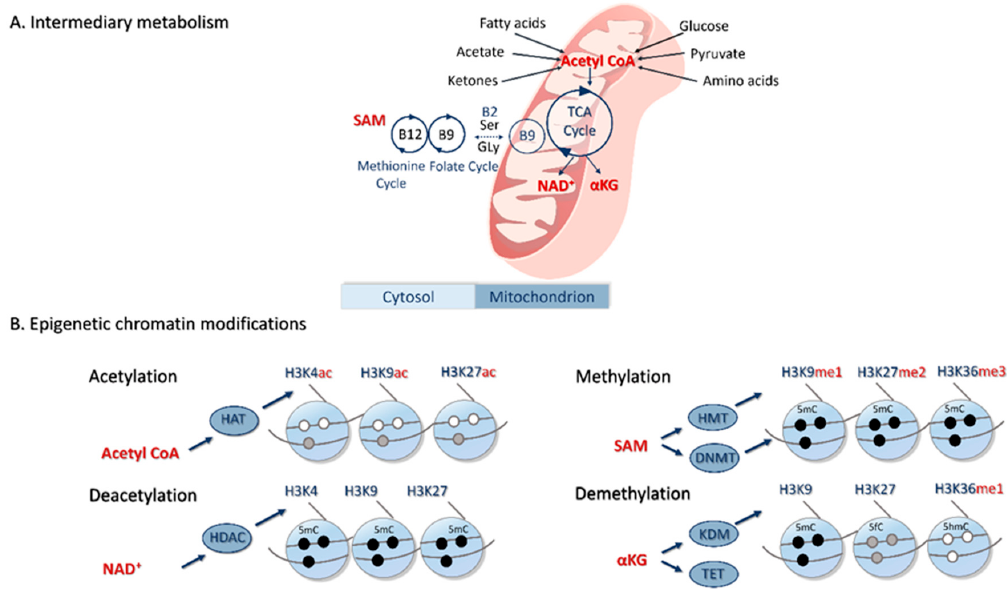
Figure 3. Alterations to intermediary metabolism ( A ) that can result in epigenetic modifications to chromatin ( B ). Intermediary metabolism can be altered directly by dietary composition (during sensitive periods; see Figure 1), and / or by eating disorders and the gut microbiome (see Figure 2). This in turn can alter the availability of various intermediary metabolites that serve as substrates and co-factors for enzymes involved in chromatin modification (Histone acetyltransferases (HAT) and Histone deacetylases (HDAC; e.g., Sirtuins), Histone methyl transferase (HMT) and DNA methyltransferases (DNMTs), Histone (lysine) (KDM) and Ten-Eleven Translocation (TET) demethylases) [80]. Only four of the better-studied intermediary metabolites (i.e., Acetyl CoA, Nicotinamide adenine dinucleotide (NAD + ), S-adenosylmethionine (SAM) and alpha-ketoglutarate ( α KG)) associated with mitochondrial metabolism are presented [81]. Similarly, the best-studied histone acetylation sites are found on various lysine (K) residues on histones H3 and H4, although they also occur on H2A and H2B. Examples of histone (lysine) (mono-[me1], di-[me2] and tri-[me3]) are presented, although arginine methylation should not be discounted [82]. Covalent modifications to DNA include 5-methylcytosine (5mC), 5-formylcytosine (5fC) and 5-hydroxymethylcytosine (5hmC) which are carefully choreographed with histone acetylation / methylation to alter the configuration of chromatin between expressive and repressive states [83]. The generation of small RNAs that can modify chromatin structure and alter transcription is not represented. TCA, tricarboxylic-acid cycle; B2, riboflavin; B9, folate; and B12, cobalamin.